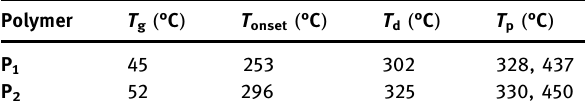
Table 3: Thermal analytic data of the polymers Polymer